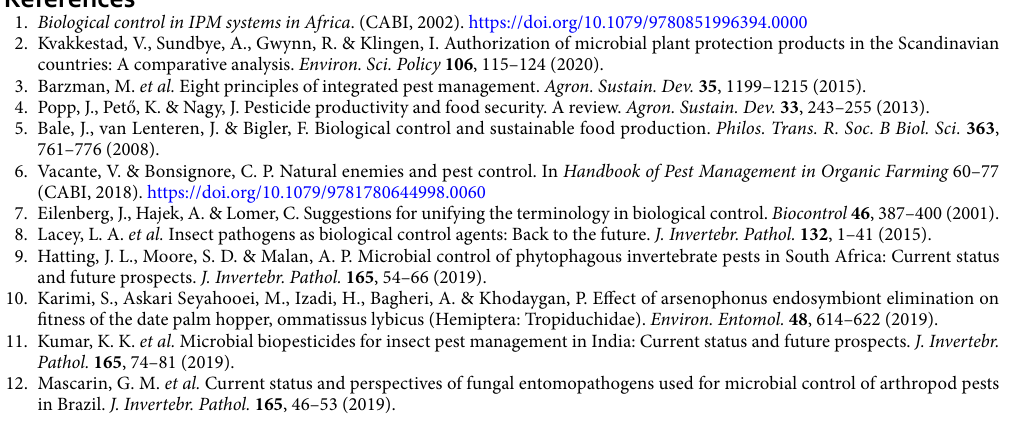
spatial variation of temperature and relative humidity to provide predictions of the entomopathogenic fungus efficiency at large scale. The process was implemented in R (V.3.6.3) 85 using several R-packages that include. Sensitivity analysis (SA), model evaluation and validation. A sensitivity analysis was performed to determine how sensitive the model output R 0 (Eq. 10) is to changes in the model parameters, which further allows to determine which climate variable (relative humidity, temperature) that have most influence on the stability/instability of the equilibrium points and on R 0 . Sensitivity analysis provides a way to measure how changes in the parameters translate into variations in R 0 . It also assesses the relative importance of different factors responsible for the efficacy of the entomopathogenic fungus as a biocontrol agent against locusts and to better determine how to improve it. Sensitivity analysis was performed by the Partial Rank Correlation Coef- ficient (PRCC) algorithm 86 , where large PRCC values (> 0.5 or < − 0.5) indicate that the parameter has a high influence (positive/negative) on the model outcome. A positive PRCC value indicates the increase of the efficacy with the increase of the parameter and a negative value indicates the decrease of the efficacy with an increase of the parameter. A recent study in some East African countries predicted the breeding area for desert locust under climate change scenario using temperature, rainfall and, sand and soil moisture content as key bioclimatic factors 68 . The maps obtained in 68 , that predicted the current and future area of suitability in Kenya was used to compare if, the locations predicted to be highly suitable for the long-term establishment of desert locust, fits with the areas predicted by the current model to be deemed adequate for applying the entomopathogenic fungus as a biocontrol agent, against locust at a specific month. Furthermore, to evaluate the ability of the spatial projection of R 0 as a tool to predict the suitable month for applying the entomopathogenic fungus as a biocontrol agent at a given location, the point coordinates of the locust incidences in the respective countries were uploaded to the maps of R 0 to compare and check how these points fit with the areas having R 0 greater than one ( R 0 > 1). All data generated or analysed during this study are included in this published article.